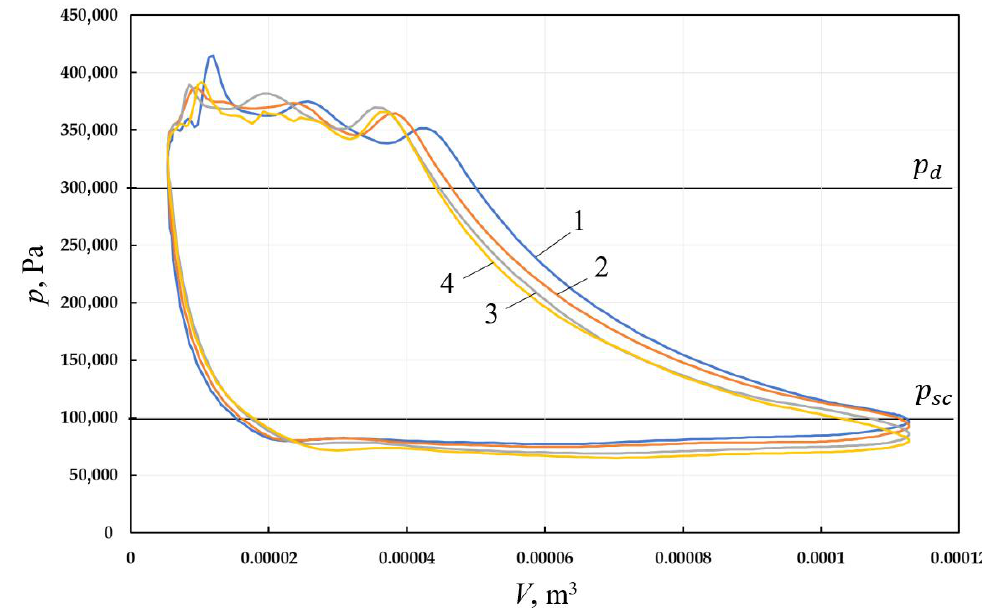
Figure 7. Indicator diagrams of the working cavity of a two-cylinder single-stage piston power machine with fluid movement due to vacuum at gas suction, obtained at different coolant flows (1—coolant flow rate is 200 mL/min; 2—coolant flow rate is 300 mL/min; 3—coolant flow rate is 400 mL/min; 4—coolant flow rate is 500 mL/min).